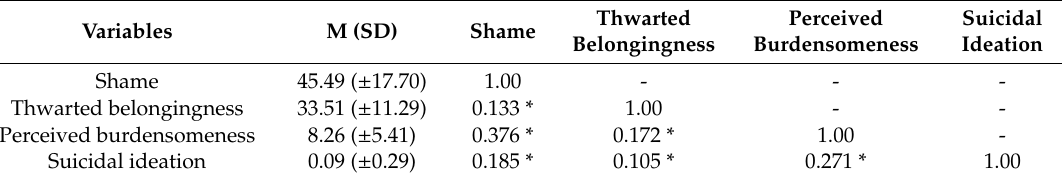
Table 2. Standard deviation and correlation matrix.